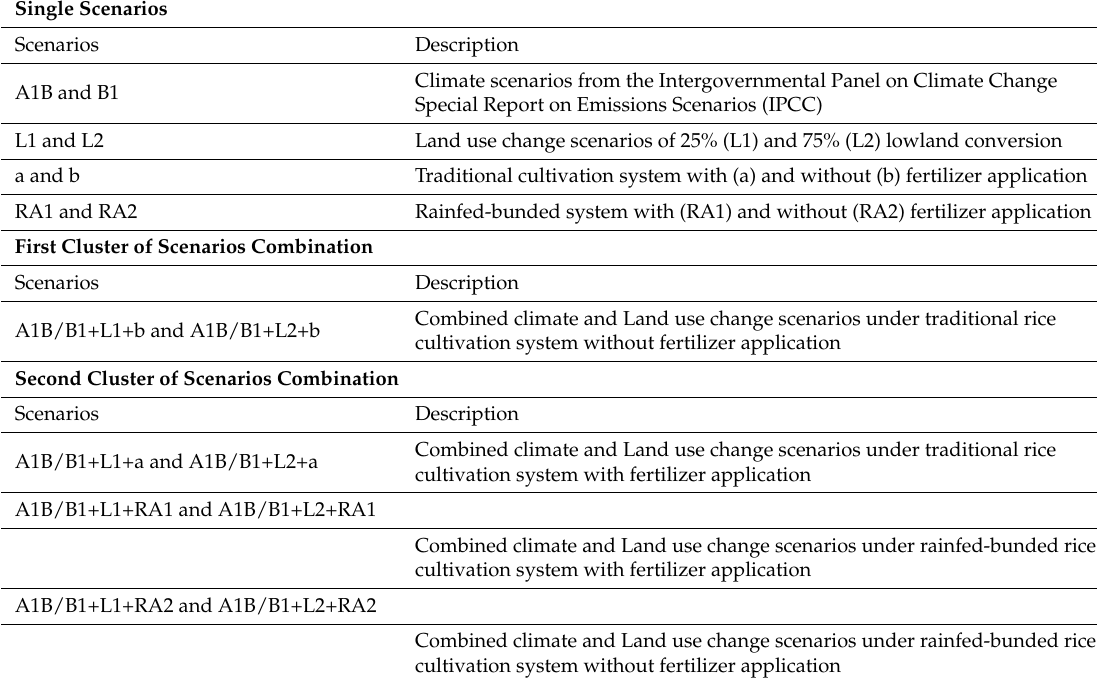
Table 1. Scenario combinations of climate, land use and